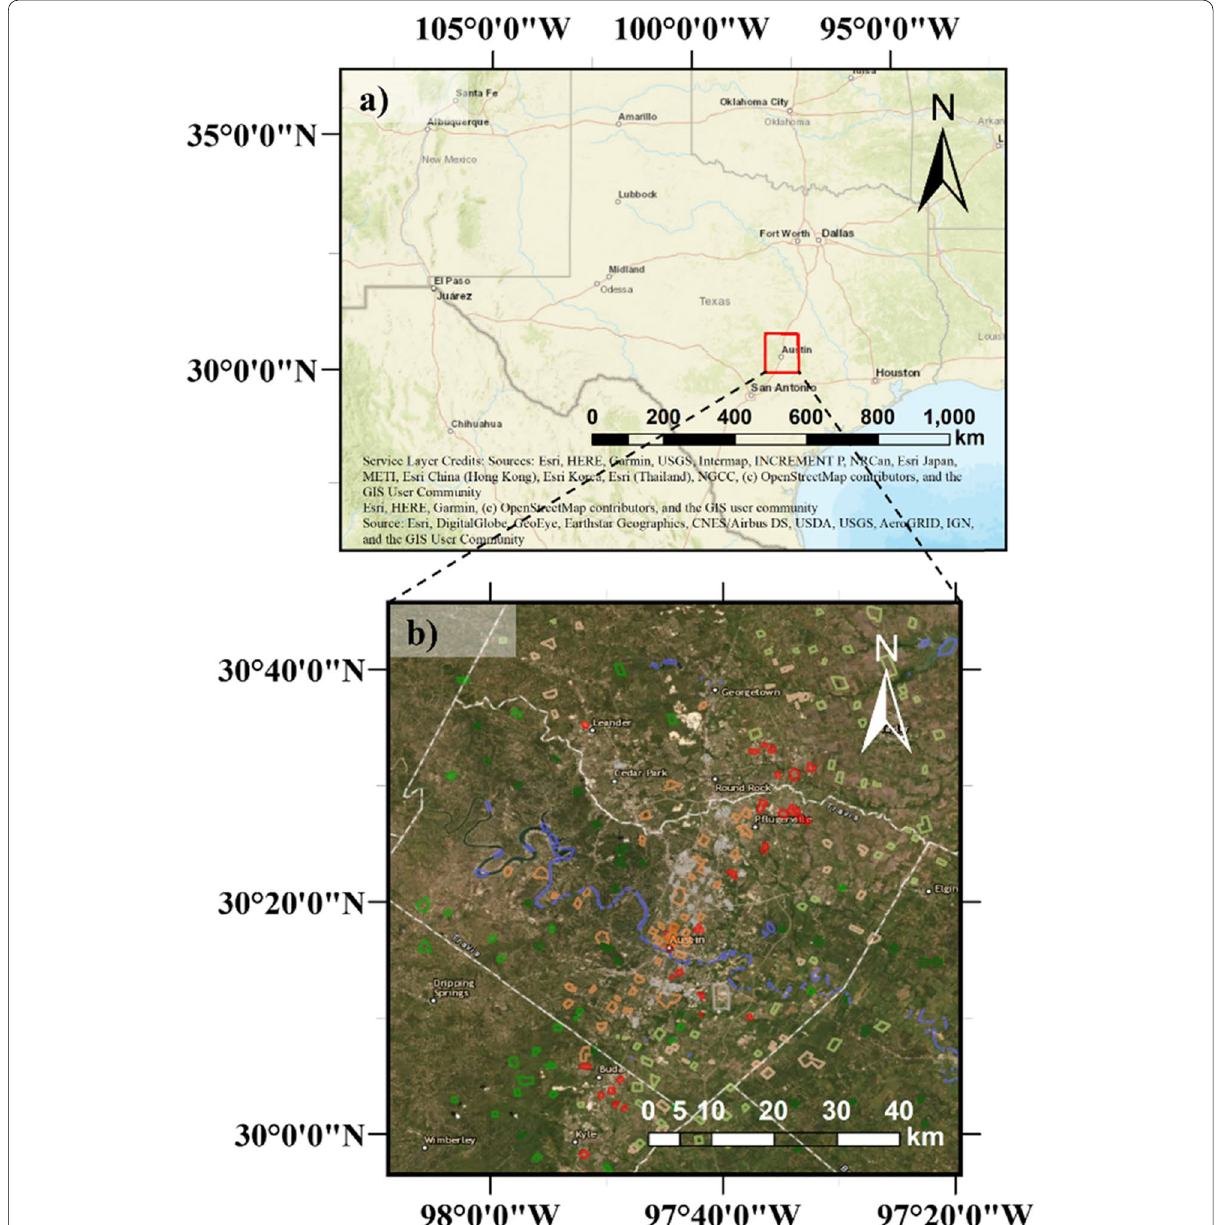
Fig. 1 a The Texas map showing the Austin ROI (red box) investigated in this study. b The zoomed‑in Austin map with training polygons for each LCZ